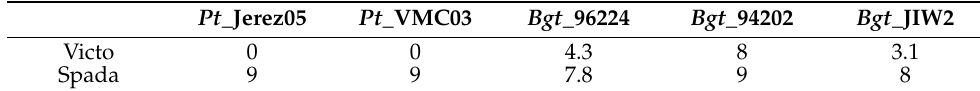
Table 1. Parental lines reaction responses (expressed as infection type) to different isolates of Puccinia triticina ( Pt ) and B. graminis ( Bgt ) tested.